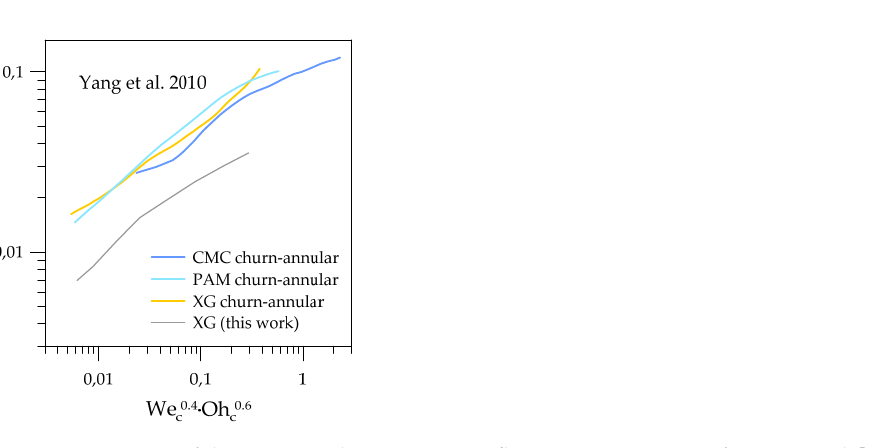
Figure 7. Comparison of the segmented-to-continuous-flow pattern transition for Yang et al. [18] and the current work in the unified dimensionless coordinates.